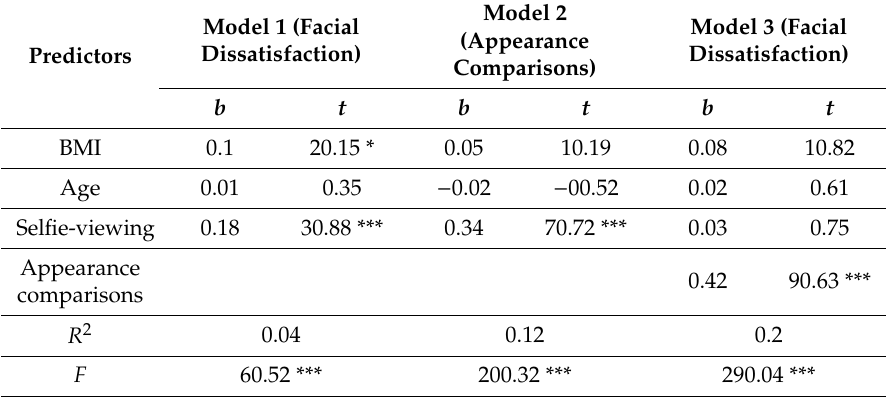
Table 2. Testing the mediation e ff ect of selfie-viewing on facial